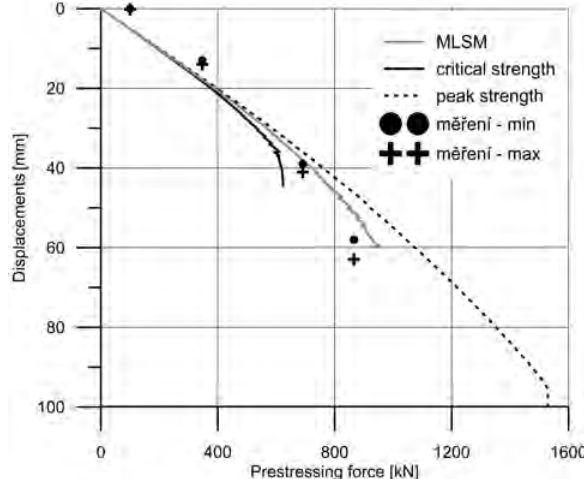
Figure 7. Predicted and measured load – displace- ment curves.